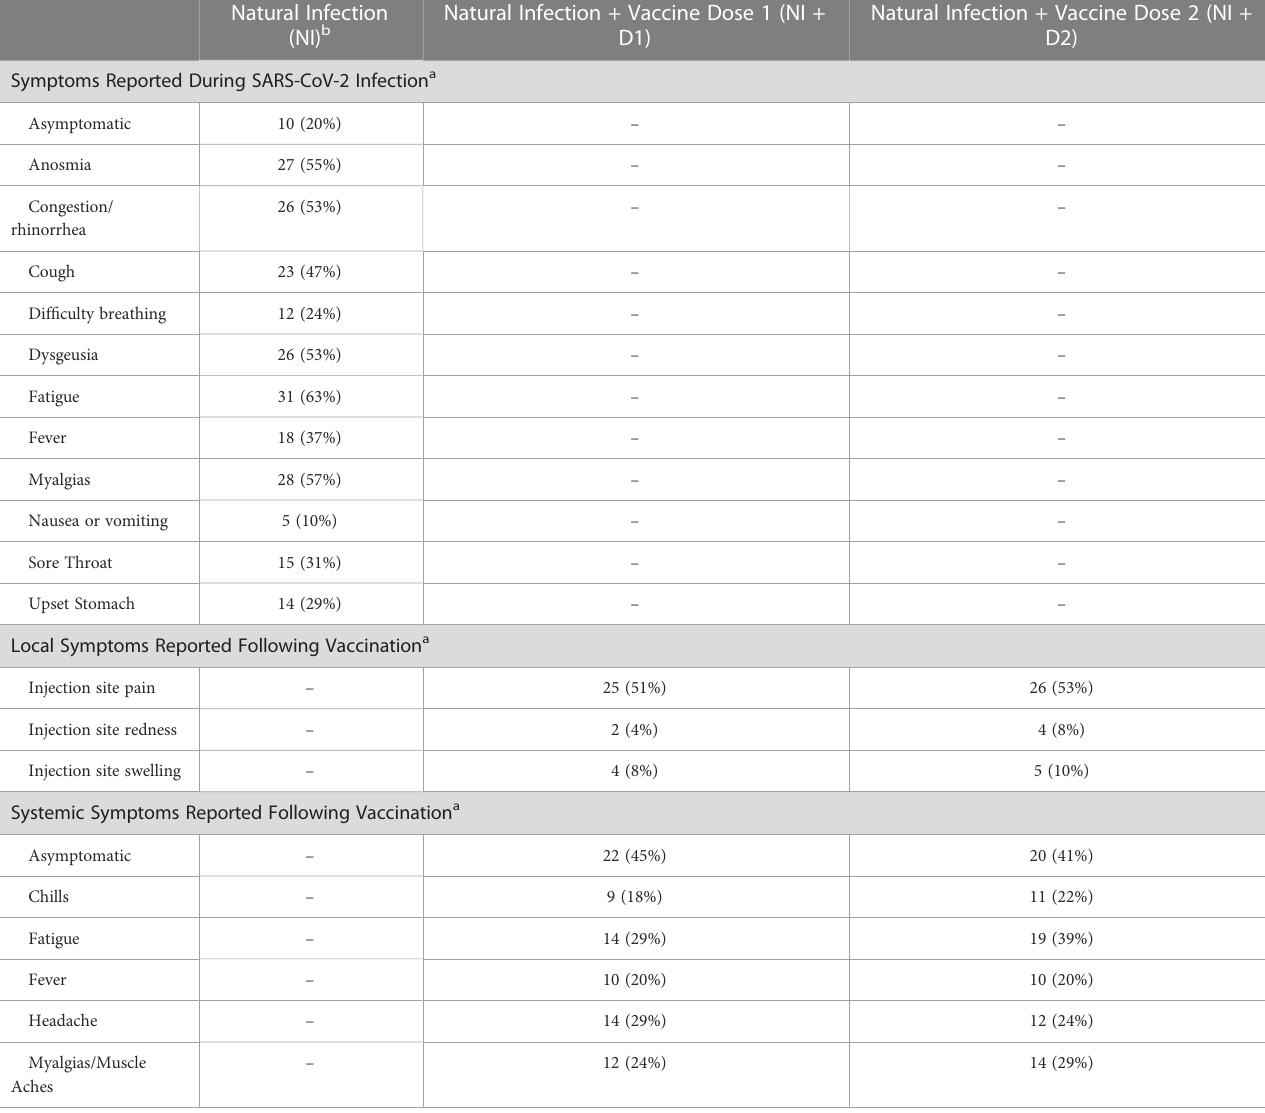
TABLE 2 Symptoms experienced by the study cohort following natural infection, 1st dose of vaccine, and 2nd dose of vaccine. Natural